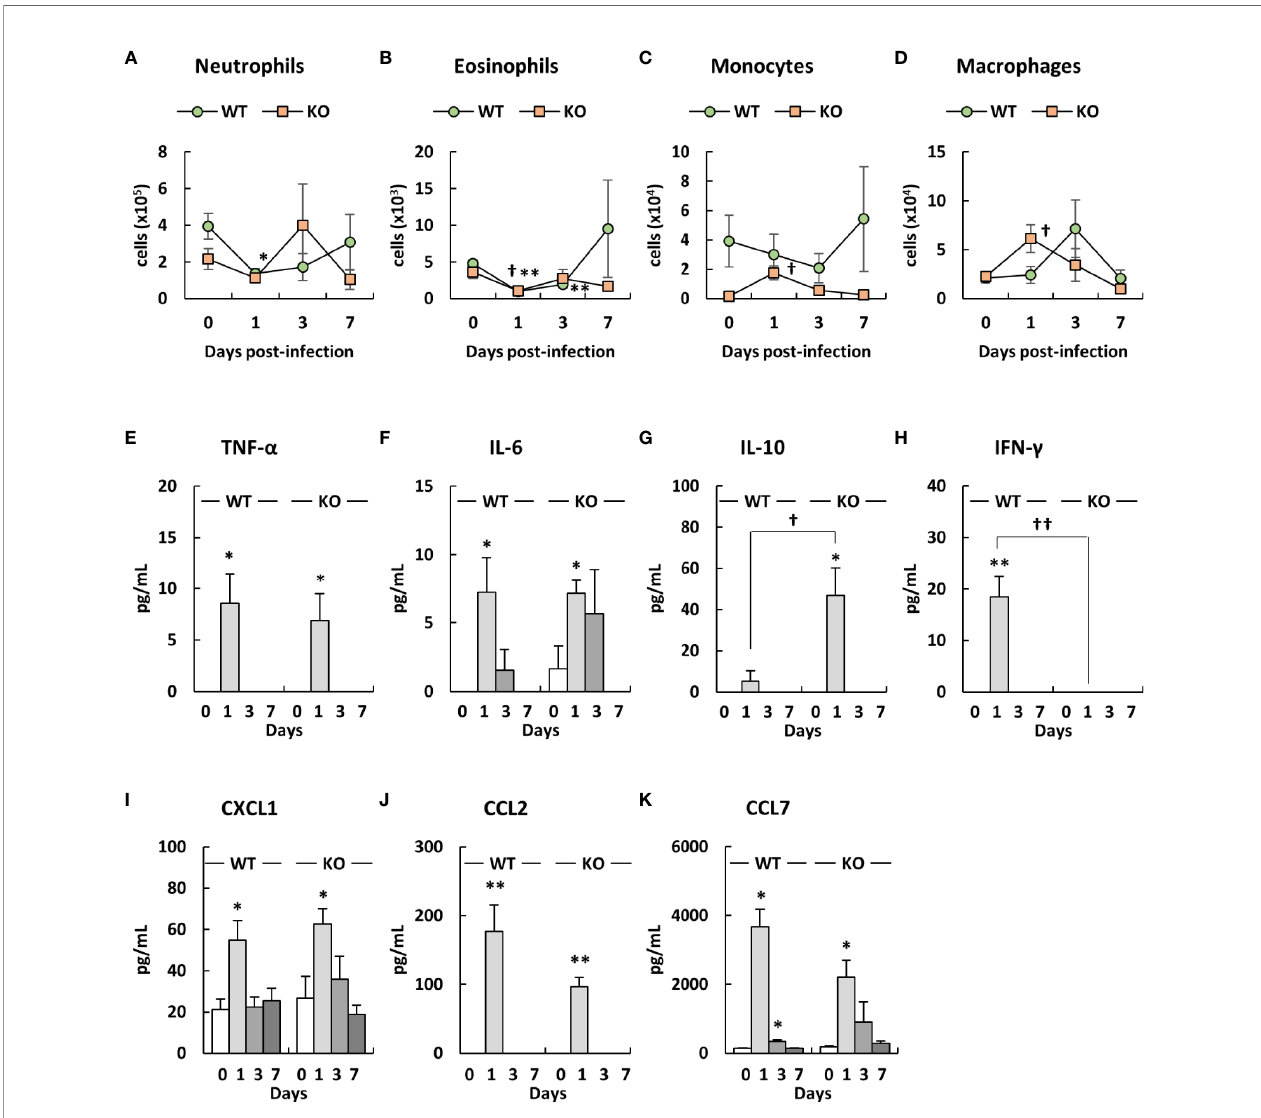
FIGURE 7 | Number of innate immune cells in the blood and proin fl ammatory cytokine expression levels in the sera of klotho wildtype (WT) and knockout (KO) mice before and after infection with Acinetobacter baumannii . Summarized results show the number of (A) neutrophils, (B) eosinophils, (C) monocytes, and (D) macrophages in the blood of A. baumannii -infected klotho WT and KO mice. Line graphs were compiled from four independent experiments ( n = 16 for WT and n = 16 for KO mice), and represent the mean ± SEM. Asterisks indicate statistically signi fi cant differences (* P < 0.05, klotho WT mice before infection vs. klotho WT mice after infection, Student ’ s t -test; †† P < 0.01, klotho KO mice before infection vs. klotho KO mice after infection, Student ’ s t -test; ‡‡ P < 0.01, klotho WT mice vs. klotho KO mice, Student ’ s t -test). The production of (E) TNF- a , (F) IL-6, (G) IL-10, (H) IFN- g , (I) CXCL1, (J) CCL2, and (K) CCL7 in the sera of klotho WT and KO mice before and after infection with A. baumannii . Bar graph data represent the mean ± SEM and were compiled from four independent experiments ( n = 16 for WT and n = 16 for KO mice). Asterisks indicate statistically signi fi cant differences (** P < 0.01; * P < 0.05, before infection vs. after infection, Student ’ s t -test; †† P < 0.01; † P < 0.05, klotho WT mice vs. klotho KO mice, Student ’ s t